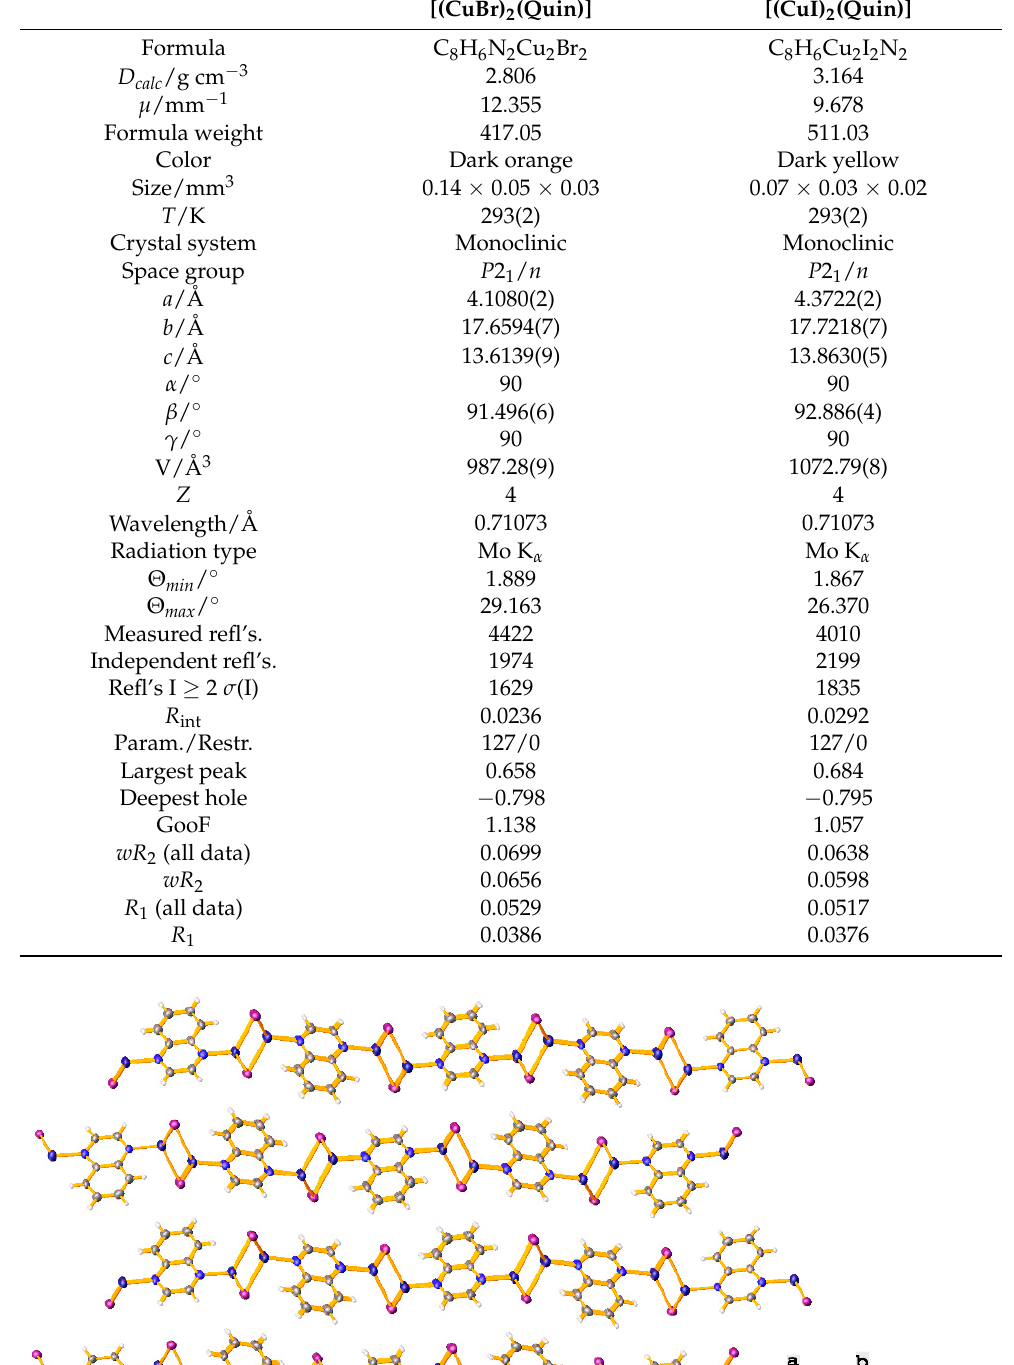
Table 1. Summary of single-crystal X-ray diffraction crystal data and structure refinement parameters for [(CuBr) 2 (Quin)] and [(CuI) 2 (Quin)] at ambient conditions.